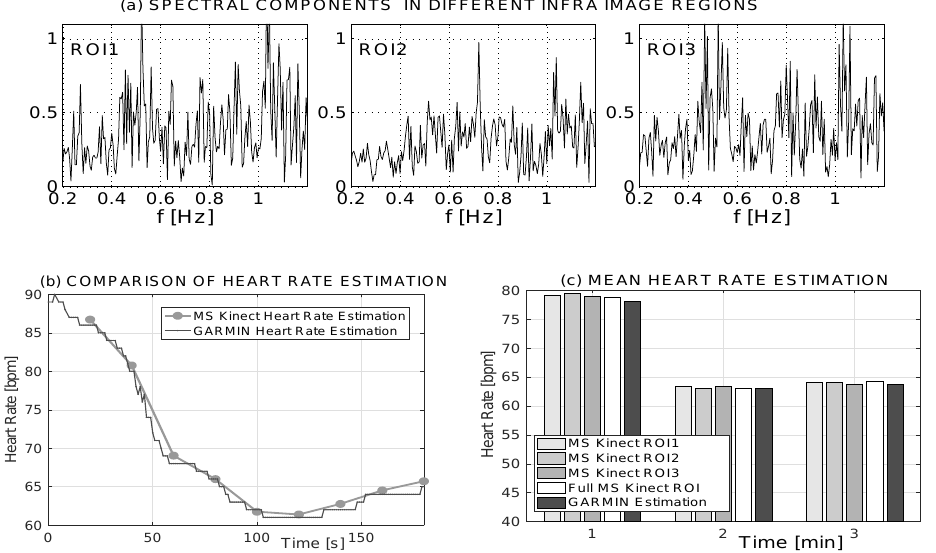
Figure 5. Heart rate estimation using MS Kinect infrared data and Garmin heart sensor data recorded with a sampling period of 1 s presenting ( a ) the infrared image spectral components in separate regions over a period of 180 s; ( b ) the evolution of heart rate using 20 s video sequences together with Garmin records; and ( c ) the comparison of mean heart rate values averaged over one minute segments and infrared values averaged over the whole mouth ROI and its three